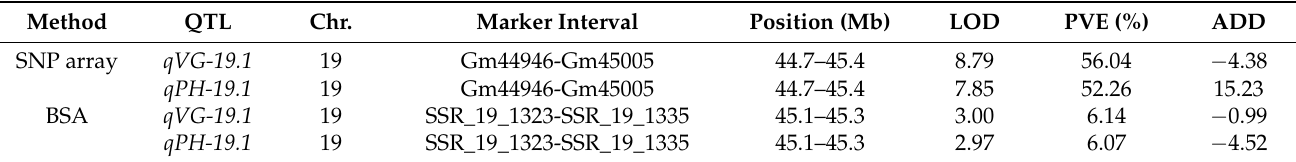
Table 2. QTLs statistics associated with VG and PH in the ZH39 × NY36-87 F 7 population.